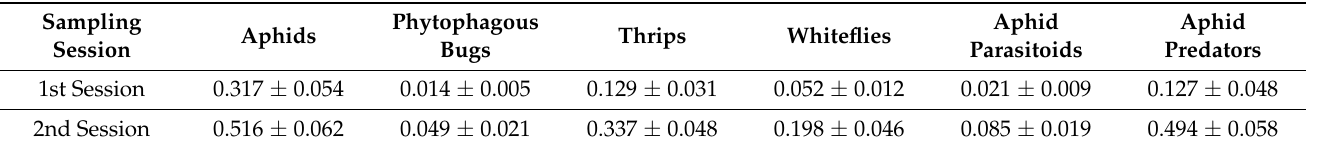
Table 2. Ratio of strawberry plants in greenhouse crops colonized by a given insect group according to the sampling session (mean ± standard